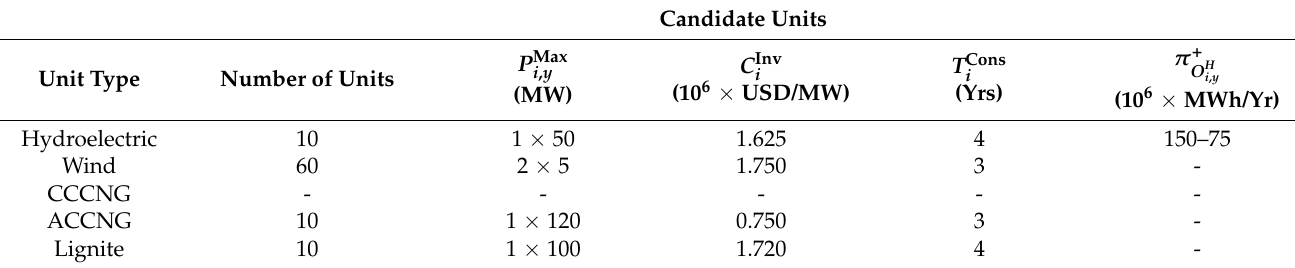
Table 4. The candidate units’ data.